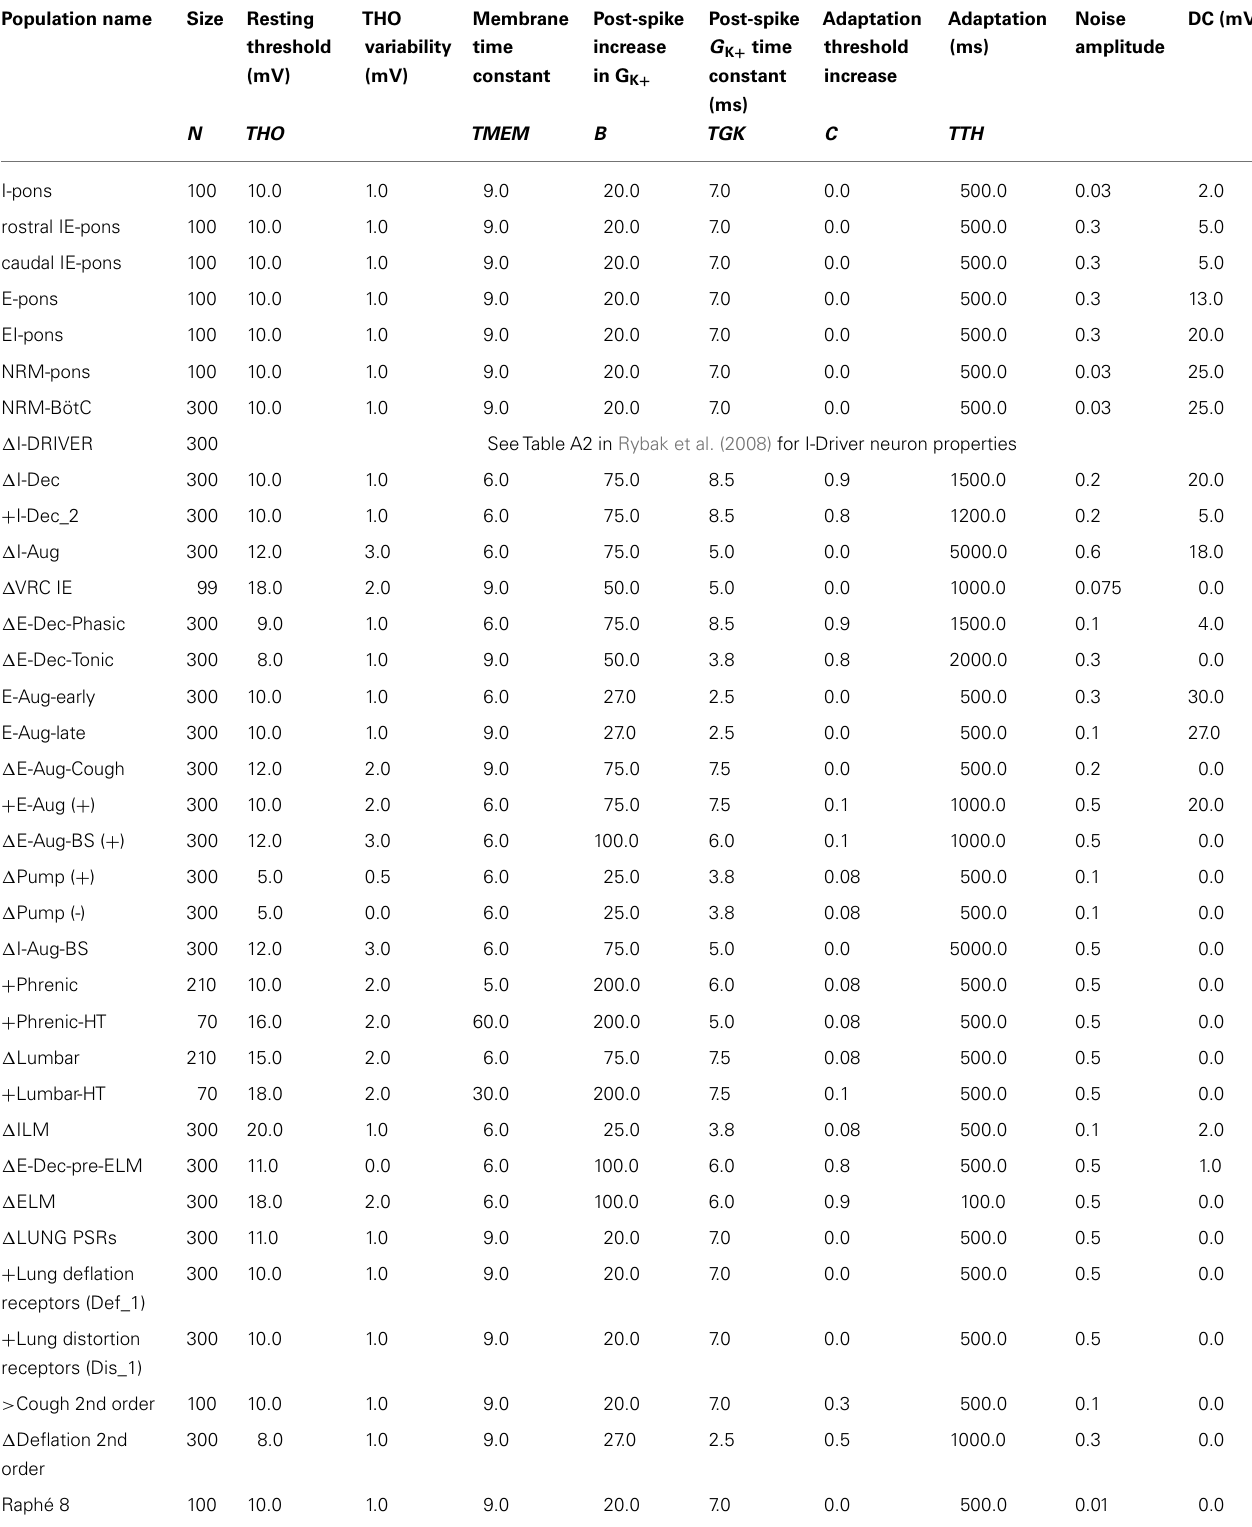
Table 2 | Population parameters for network model with adjusted ( ∆ ) and additional ( + ) neuronal populations modified from Poliaˇcek et al.